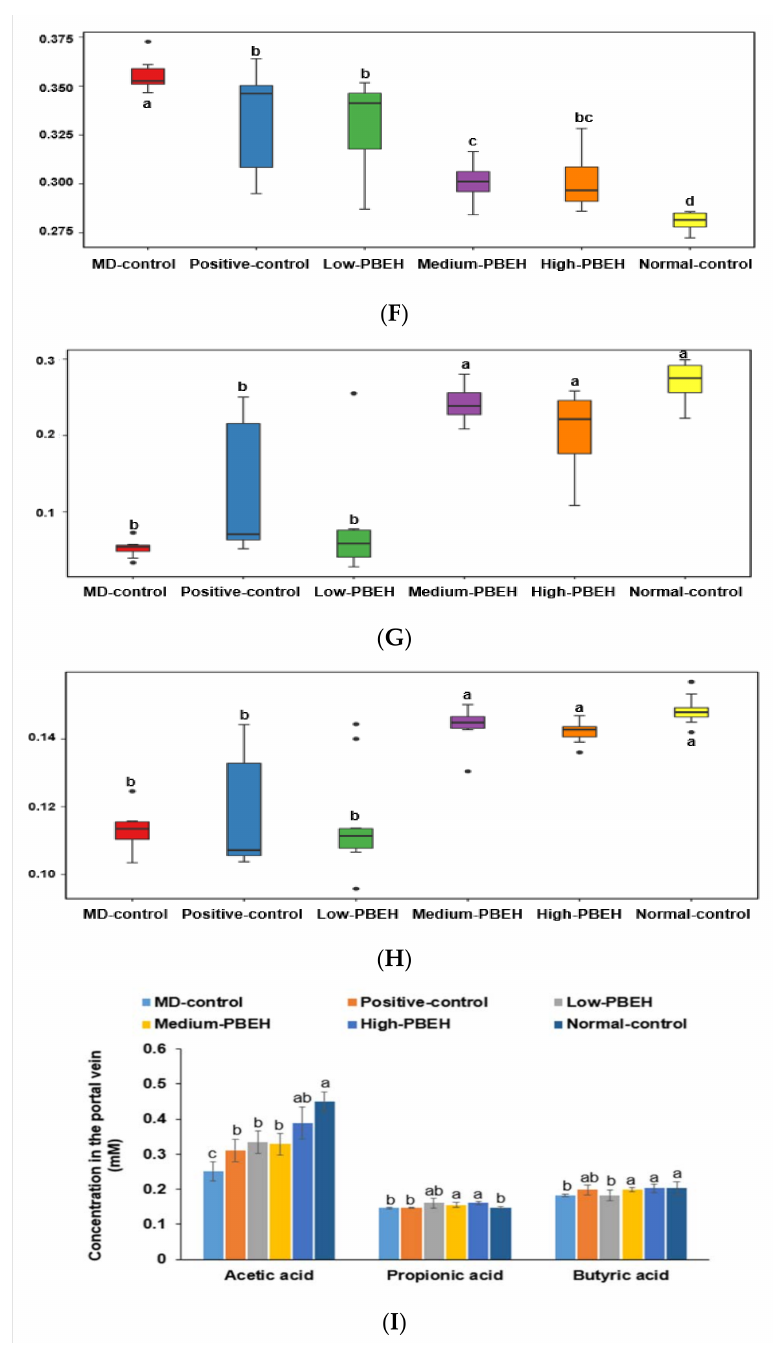
Figure 5. Gut microbiome functions and short-chain fatty acids in the portal vein. Male rats had intraperitoneal injections of scopolamine (2 mg/kg body weight/day) at 30 min after daily feed- ing of casein (MD-control), porcine brain enzyme hydrolysates (PBEH; 7 mg total nitrogen/mL) at 0.053 mL (Low-PBEH), 0.159 mL (Medium-PBEH), 0.478 mL (High-PBEH), or 10 mg donepezil (Positive-control) per kilogram body weight per day for six weeks. ( A ) Glycolysis (Embden–Meyerhof pathway), glucose → pyruvate; ( B ) pyruvate oxidation, pyruvate → acetyl-CoA; ( C ) beta-oxidation, acetyl-Co A synthesis; ( D ) citrate cycle (TCA cycle); ( E ) leucine degradation, leucine → acetoac- etate + acetyl-CoA; ( F ) fatty acid biosynthesis, initiation; ( G ) bile acid biosynthesis, cholesterol → cholate/chenodeoxycholate; ( H ) 3-Hydroxypropionate bi-cycle. ( I ) Bars and error bars represent the means ± standard deviations ( n = 10). a–d Different superscript letters on the bars indicate a significant difference among the groups by Tukey test at p <